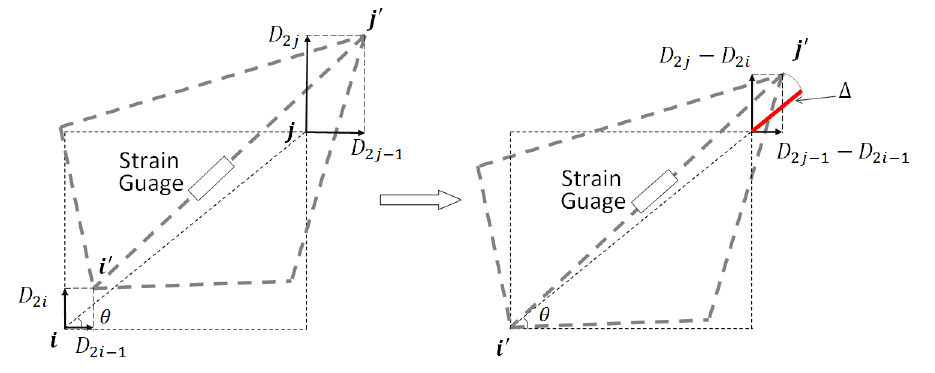
Figure 2. General exaggerated deformation of part of the truss structure ( Left )—translated deformed shape to coincide the node “ i ” with its initial undeformed shape ( Right ).